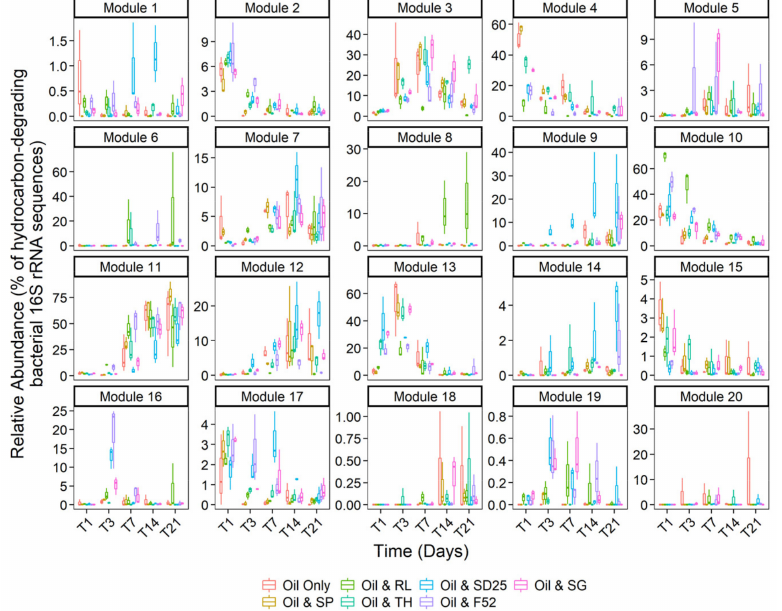
Figure 6. Relative abundances of modules based on clustering of a SPIEC-EASI co-occurrence network of ASVs from bacterial genera associated with hydrocarbon degradation. The total relative abundance (as a proportion of bacterial genera associated with hydrocarbon degradation) of ASVs in each module across the course of the experiment, based on counts of 16S rRNA sequences. All microcosms contained seawater, nutrients, and oil (NSO-1 0.1% v / v ), and some also contained additional dispersants or biosurfactants (0.005% v / v ; 20:1 ratio of oil). Dispersant and biosurfactant codes are as follows: SP = sophorolipid, RL = rhamnolipid, TH = trehalolipid, SD25 = Superdispersant 25, F52 = Finasol OSR 52, and SG = Slickgone